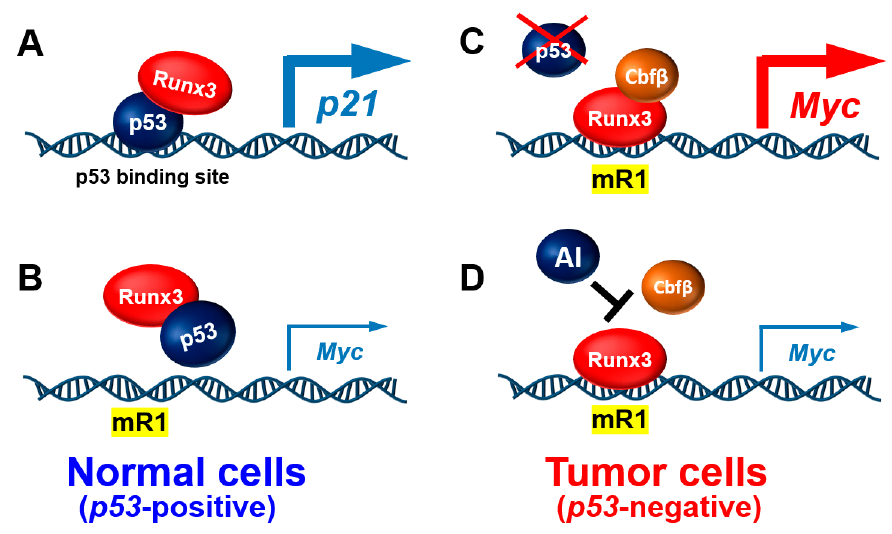
Figure 4. p53 status is the contextual determinant of whether Runx3 functions as a tumor-suppressor or an oncogene. ( A , B ) In p53 -positive normal cells, Runx3, whose transcriptional activation is inhibited by p53, acts as a co-activator of p53 in a tumor-suppressive manner and upregulates p21. ( C , D ) In p53 -negative tumor cells, Runx3 is unleashed from p53 and strongly upregulates Myc as an oncogene. In this context, treatment with a Runx inhibitor (AI-10-104; AI) is e ff ective.